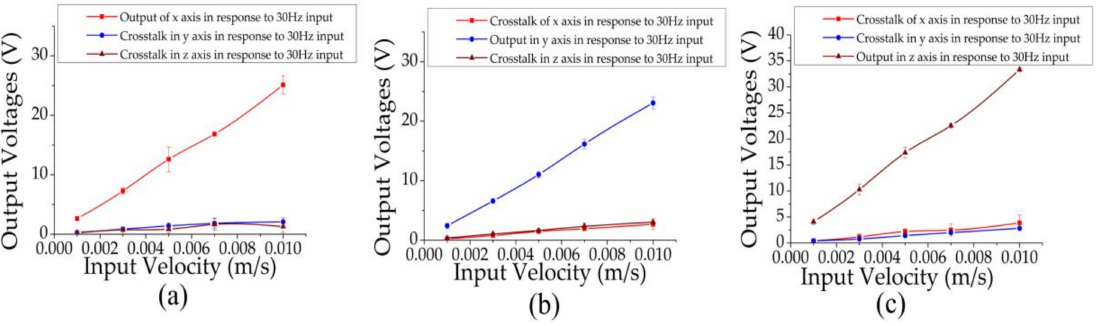
Figure 6. Independent output voltages along x , y , and z axes in response to the input vibration at 30 Hz along x ( a ), y ( b ), and z axes ( c ), where huge differences between the input axial outputs and the others proved that when the vibration along an axis input, the crosstalk caused by the other axis can be